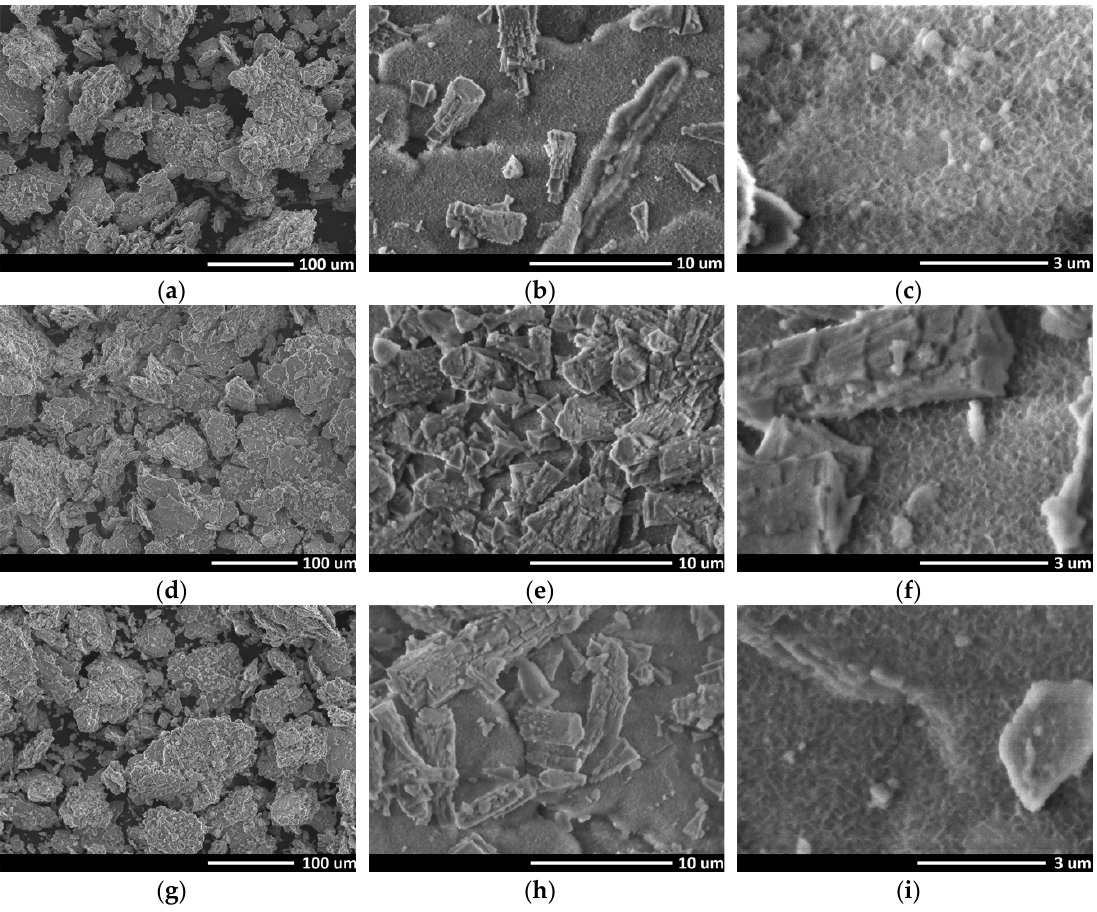
Figure 3. SEM images: ( a – c ) initial byproduct after the aluminum/water reaction (mainly Al(OH) 3 ), ( d – f ) the boehmite (AlO(OH)) after aluminum hydroxide heated at 280 °C, ( g – i ) the gamma alumina after aluminum hydroxide heated at 500 °C.